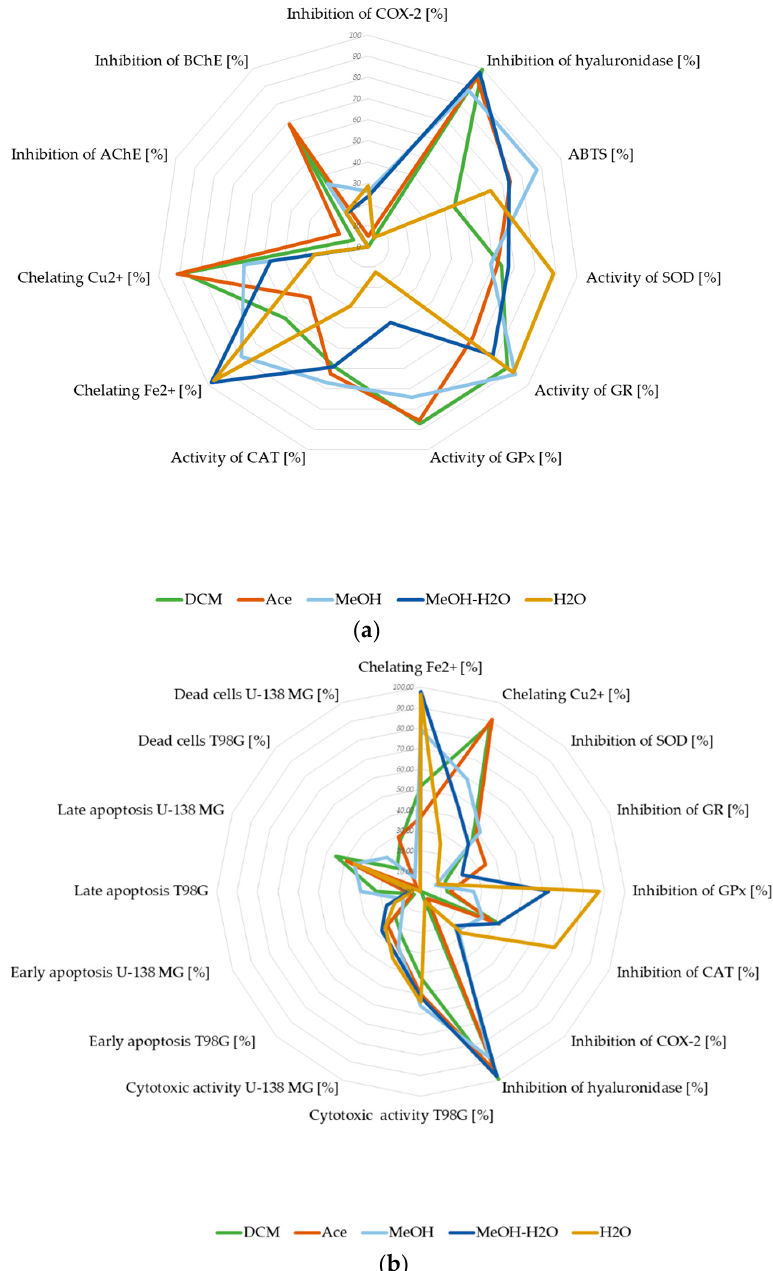
Figure 11. The biological potential of P. glauca extracts: neuroprotective potential ( a ) and anti-GBM potential ( b ), expressed in % of appropriate types of biological activity. The graphs were made for the final concentrations: ABTS •+ 0.381 mg/mL ( a ); inhibition of AChE 0.800 mg/mL ( a , b ); inhibition of BChE 0.800 mg/mL ( a ); chelating Fe 2+ 1.6 mg/mL ( a and b ); chelating Cu 2+ 0.4 mg/mL; inhibition of COX-2 0.348 mg/mL ( a , b ); inhibition of hyaluronidase 1.25 mg/mL ( a , b ); activity/inhibition of SOD 0.250 mg/mL ( a , b ); activity/inhibition of GR 0.124 mg/mL ( a , b ); activity/inhibition of GPx 0.328 mg/mL ( a , b ); activity/inhibition of CAT 0.102 mg/mL ( a , b ); cytotoxicity expressed as % of cell death: U-138 mg 0.05 mg/mL ( b ), and T98G 0.05 mg/mL ( b ); early apoptosis U-138 MG 0.05 mg/mL; early apoptosis T98G 0.05 mg/mL. The activity of antioxidants enzymes was calculated from the difference between 100% of enzyme activity and % of the experimentally evaluated enzyme inhibition.